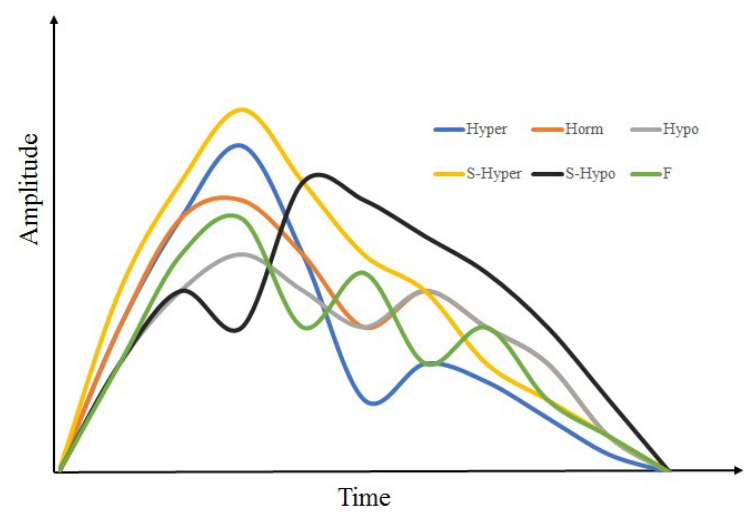
Figure 9. Basic classes of bioimpedance signals in human limbs.